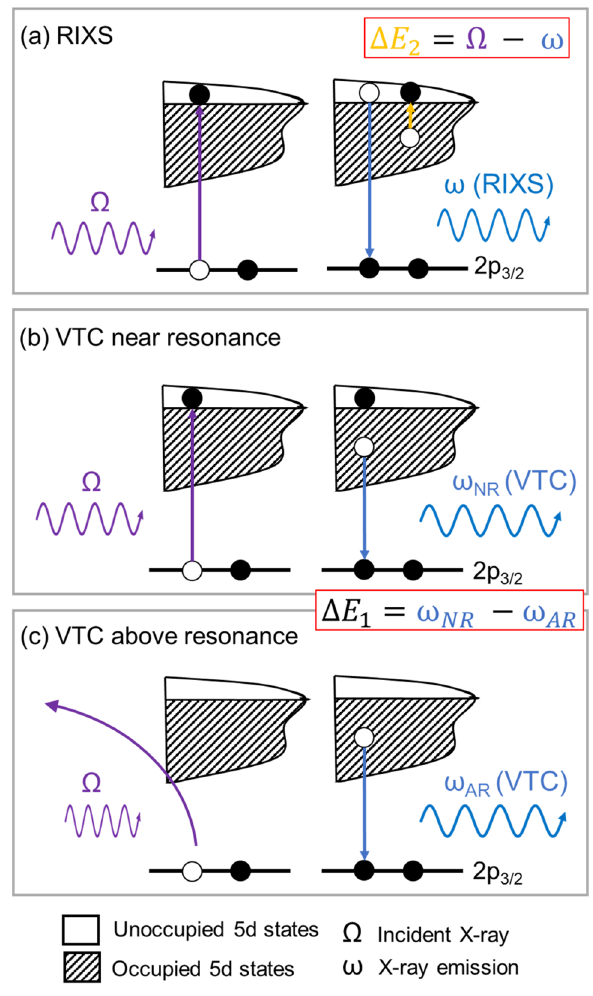
Figure 1. X-ray emission process associated with the Pt d band including the ( a ) RIXS, the decay of the intermediate state and the shakeup process (valence excitation) are a concerted process; ( b ) VTC near Pt L 3 -edge; and ( c ) VTC above Pt L 3 -edge. ω NR and ω AR represent the VTC X-ray emission with excitation near resonance and above resonance, respectively as defined in the